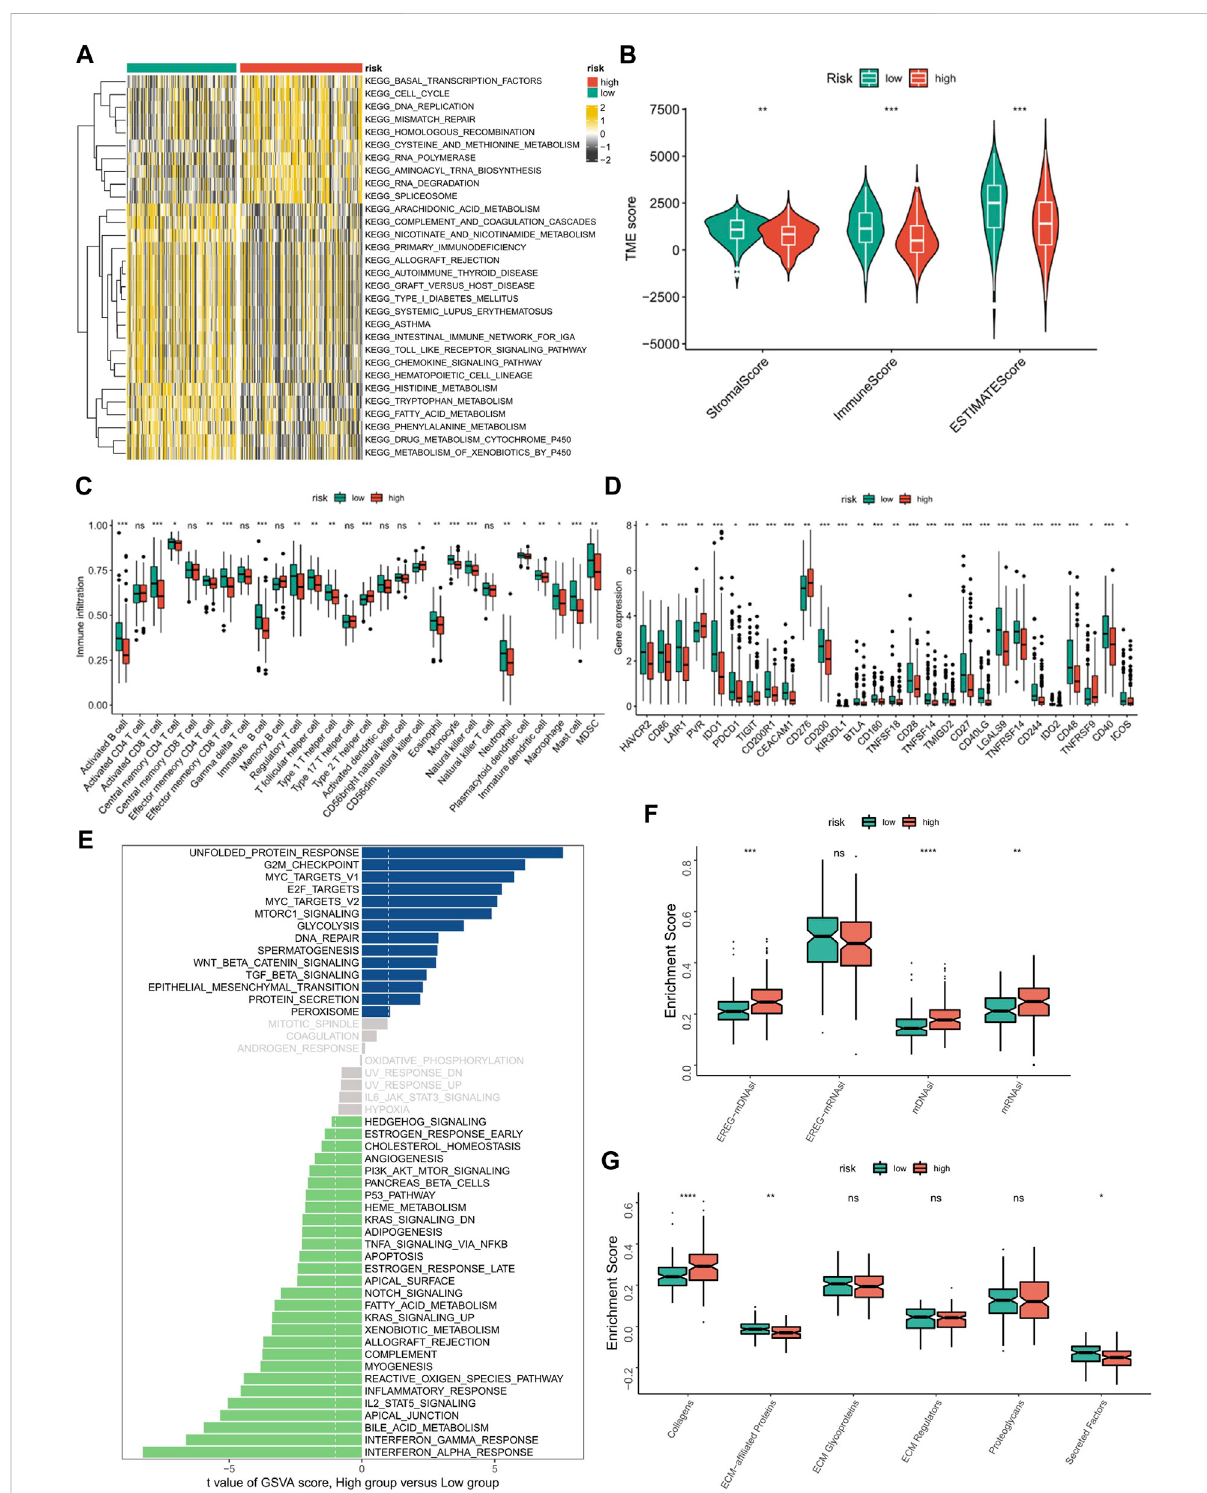
FIGURE 8 Evaluation of tumor microenvironment, immune cell in fi ltration, and immune checkpoint genes in distinct groups. (A) The heatmaps of GSVA showed signaling pathways between different risk groups. (B) Comparison of TME score between the high- and low-CRLncSig groups. (C) Differences in the in fi ltration of immune cells between the distinct risk groups. (D) The expression level of immune checkpoint genes between the high- and low-CRLncSig groups. (E) Differences in signaling pathways between different risk groups. (F) The differences in stemness index between the high- and low-CRLncSig groups (G) The different extracellular matrix components between the high- and low-CRLncSig